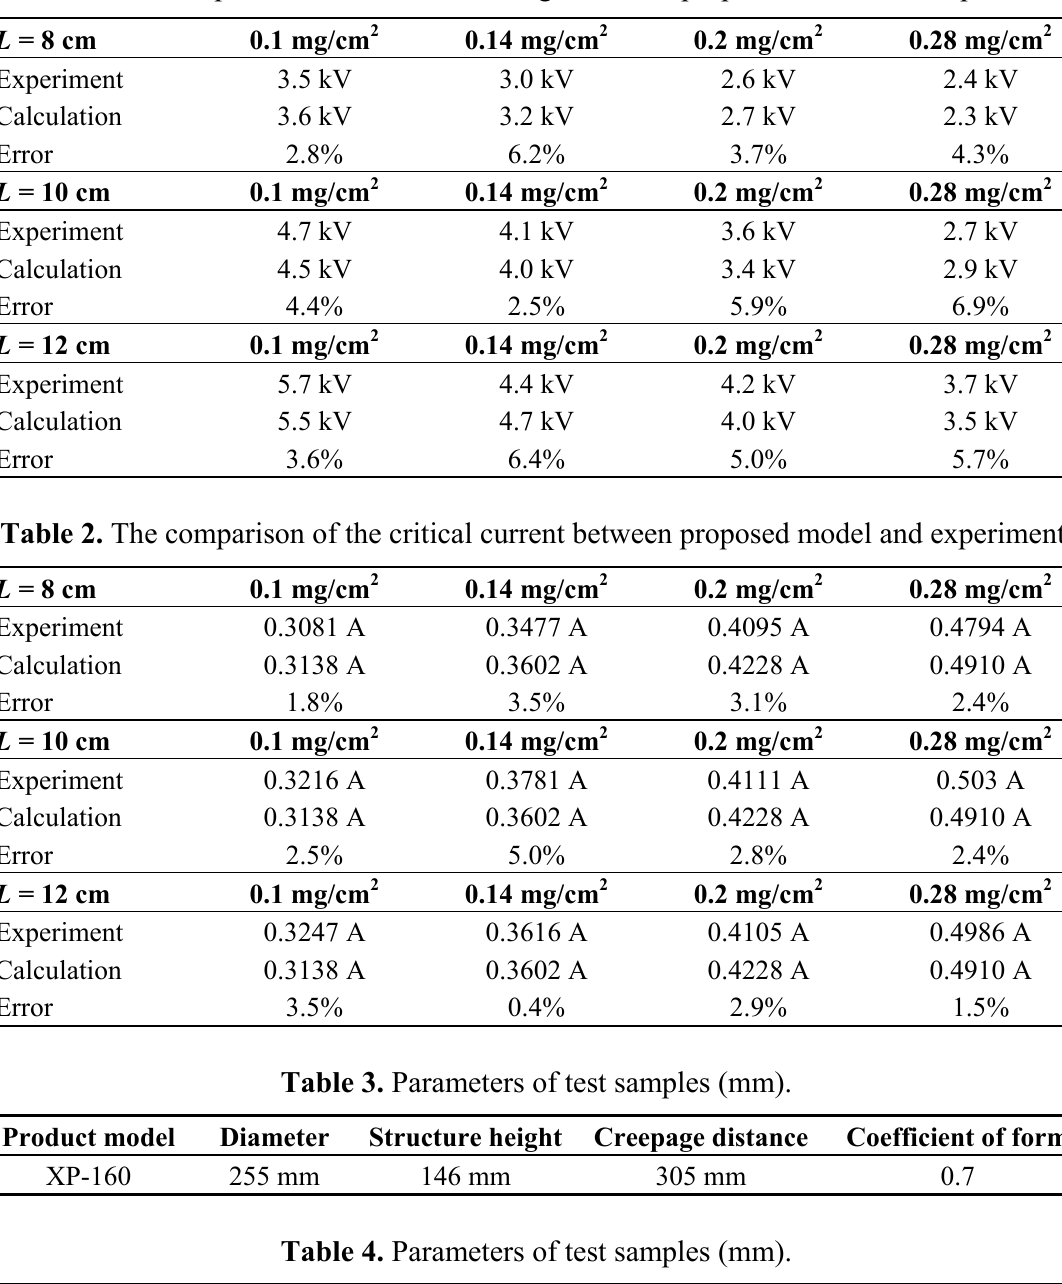
Table 1. The comparison of the critical voltage between proposed model and experiment.